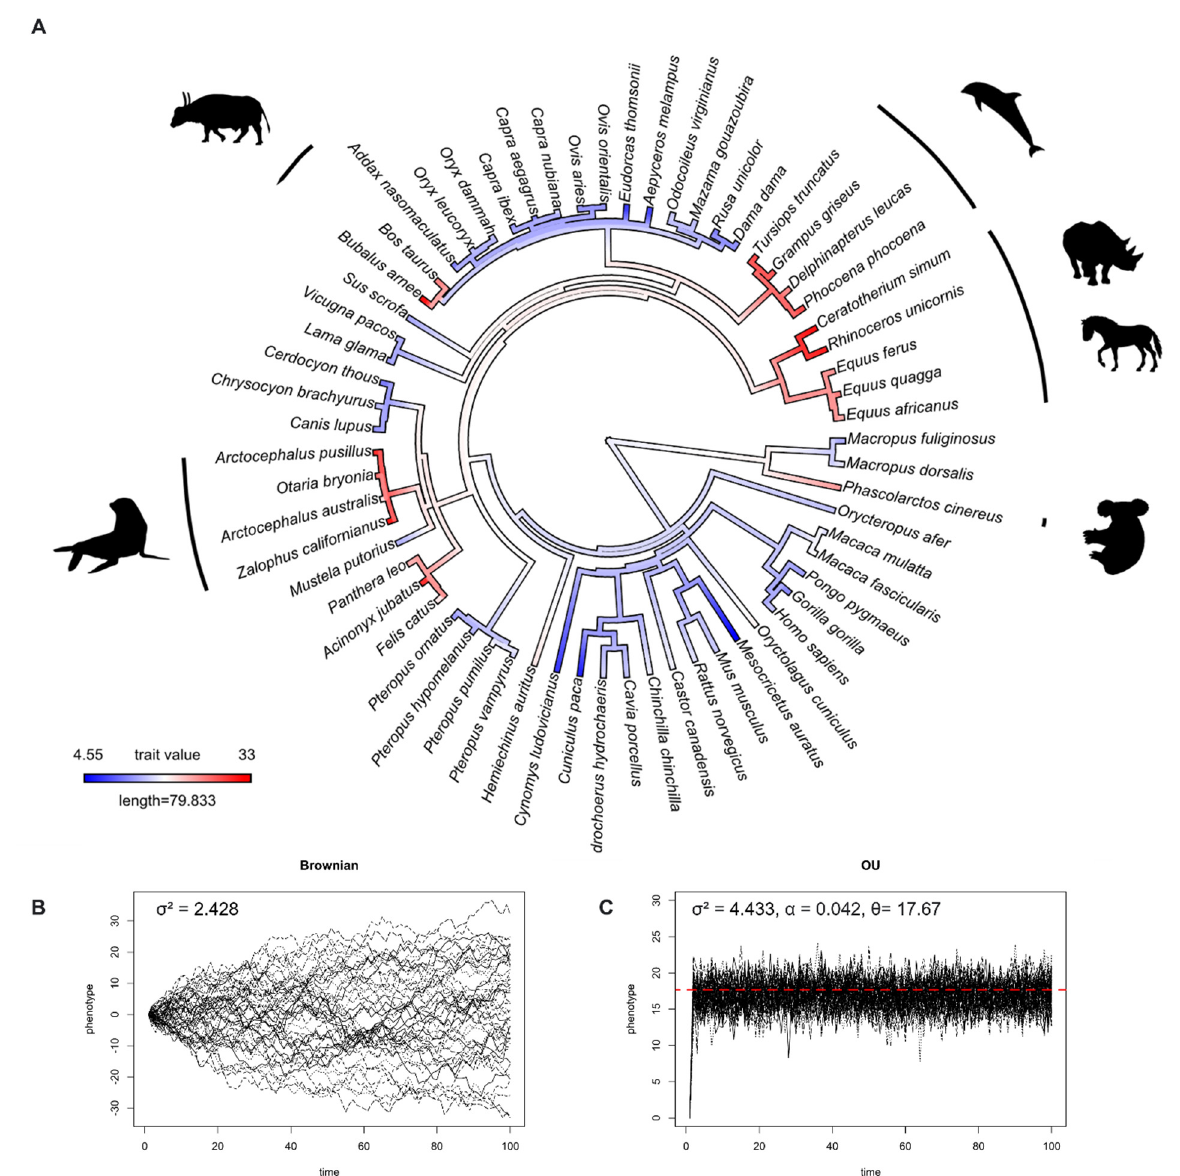
Figure 1. ( A ) Ancestral state reconstruction of intraocular pressure (IOP) from 63 species of mammals. Dark red color represents high IOP, and dark blue color represents low IOP. ( B ) Simulations of IOP evolution under Brownian model with evolutionary rate (drift) parameter ( σ 2 ). ( C ) Simulations of IOP evolution under the OU model with evolutionary rate (drift) parameter ( σ 2 ), pull rubber band (or pull towards optimum) parameter ( α ), and optimum trait value ( θ ). Red dashed line represents optimum value.